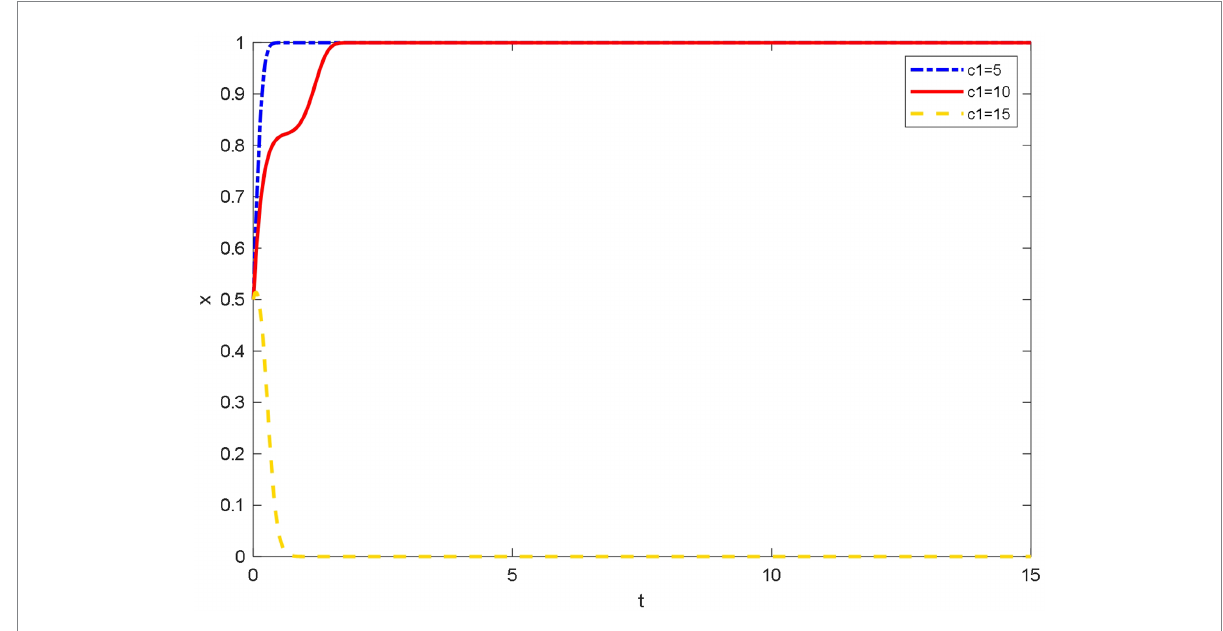
FIGURE 5 Evolutionary trajectory of doctor’s strategy selection under different registration